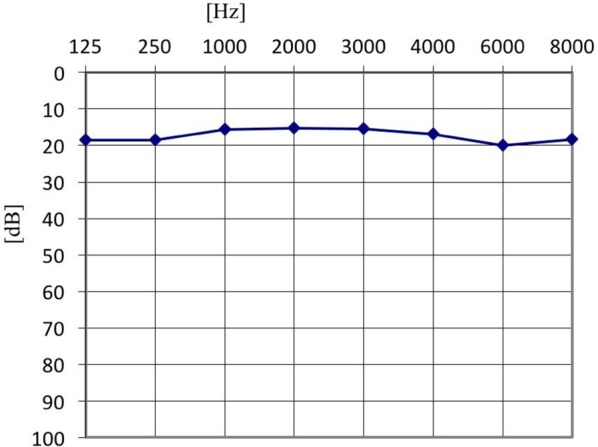
The averaged pure tone audiogram in tinnitus group–normal hearing tinnitus patients.